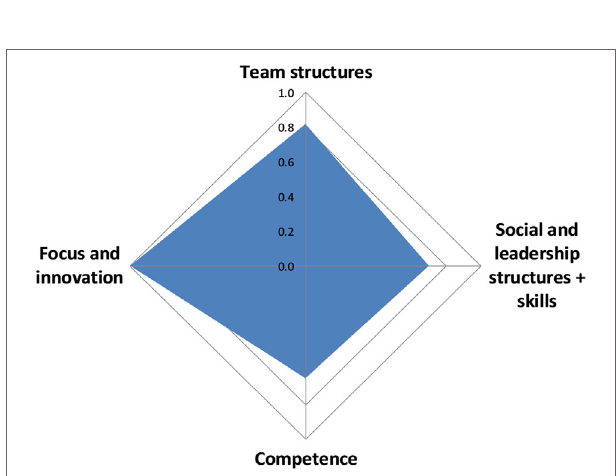
FigUre 9 | Assessment of information and data sharing in the Southern African Centre for Infectious Disease Surveillance.